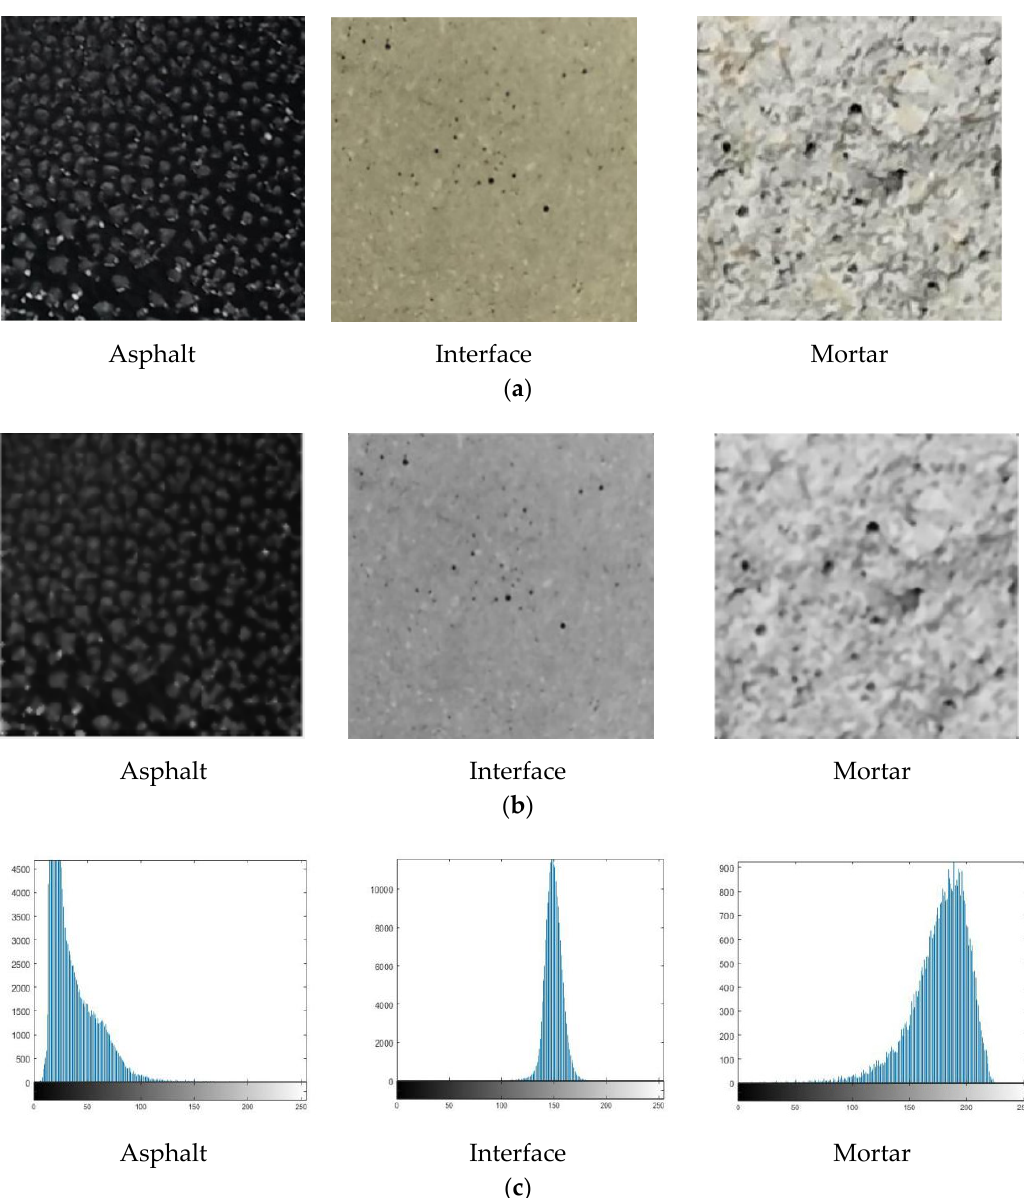
Figure 10. Picture processing of the asphalt, interface, and mortar materials. ( a ) Original image, ( b ) Gray image, ( c ) Gray Figure 10. Pictureprocessingof theasphalt, interface, andmortar materials. ( a ) Originalimage, ( b ) Grayimage, ( c ) histogram.